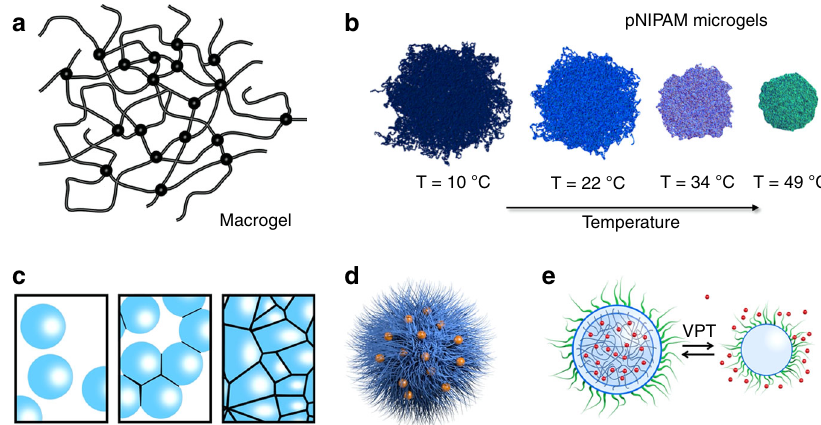
Fig. 1 Polymer microgel morphology, swelling, packing, and functionality. a Sketch of a macroscopic polymer gel with a statistically homogeneous distribution of permanent or reversible cross-links. In a good solvent, the gel is swollen, and the degree of swelling is controlled by a balance between the mixing entropy, favoring swelling, and the elastic penalty when stretching the polymer chains between cross-links 21,36 . b Volume-phase transition (VPT) of stimuli-responsive microgel particles. Microgels are colloidal-sized polymer gels, typically with a radius of 1 μ m or less, where the crosslinker density is usually decaying from the center to the periphery 1,27 . The polymers in the network can be neutral (nonionic) or carrying charged groups. The images shown are adapted with permission from ref. 75 (Copyright American Chemical Society, 2017) and depict the results from atomistic computer simulations of neutral microgels with a cross-link gradient and modeled at different temperatures. The polymer represents pNIPAM, poly-N-isopropylacrylamide, which has a lower critical solution temperature (LCST) in water of T LCST ≃ 32 °C 81 . In agreement with experiments, the simulations show that below T LCST , the microgel colloid is highly swollen while above it collapses. c Swollen microgels are soft and compressible spheres, in osmotic equilibrium with the solvent phase and other microgels. At higher concentrations, particles pack densely and form a crystal or amorphous phase. With increasing total polymer concentration, the microgel particles become compressed, facet, and shrink 4 , details of which have a profound impact on the effective pairwise interactions 91 and the macroscopic fl ow properties 25 . d By attaching metallic nanoparticles, such as gold, or by encapsulating pharmaceutically active substances, functional microgels can be obtained 12,13 . The mean distance between plasmonic nanoparticles can be probed optically, and microgels with the appropriate polymer chemistry can act as sensors 10,11 . e Triggering the VPT by temperature, pH, or optically can be used to expel molecules in a biological environment in a controlled way and at a targeted site. The graphic, adapted with permission from ref. 24 (Copyright 2013 Wiley Periodicals, Inc.), shows a sketch of a microgel particle fi lled with small active molecules (red dots) and decorated with polyethylene glycol (green hairs) to improve